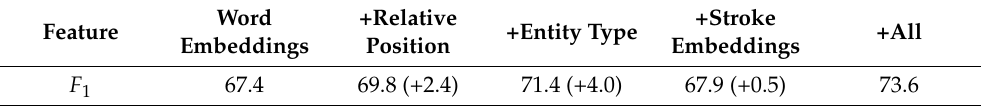
Table 8. Results of relation